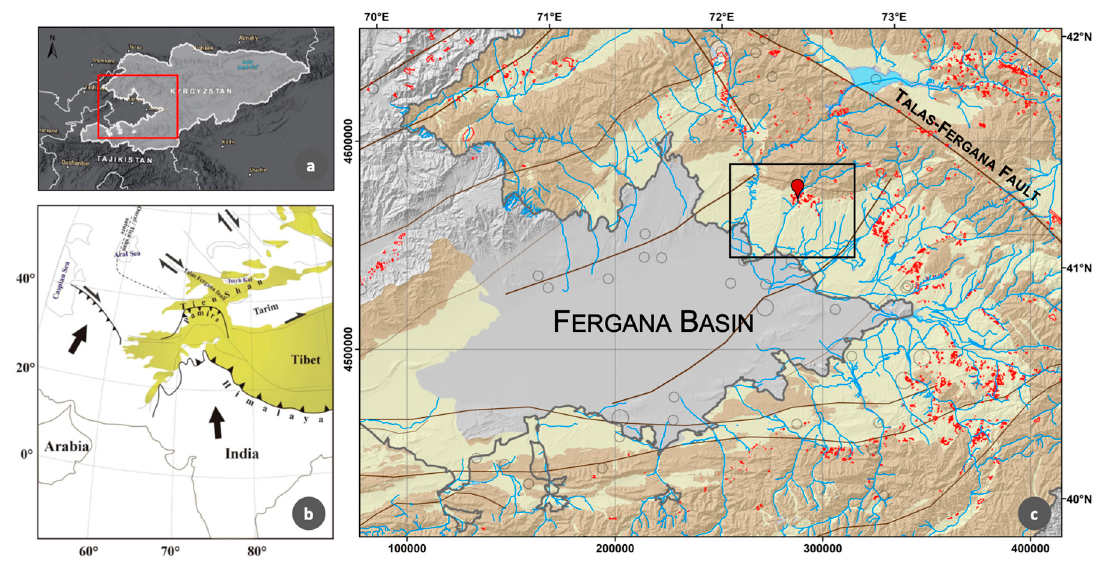
Figure 1. ( a ) Location of Kyrgyzstan and the Fergana Basin (see the red square). ( b ) Tectonic map representing the collision between the Eurasian and Indian plates. The regions located at altitudes < 2000 m are colored in green [26]. ( c ) Fergana Basin and the Mailuu-Suu Valley (see the black square) on the simplified geological map of the Western Tien Shan. Zones colored in beige represent Cenozoic, Mesozoic soft rocks, and sediments, while zones in brown indicate Pre-Mesozoic and magmatic rocks. The circles show the location of major (M ≥ 5.5) earthquake epicenters and the red dots represent the landslides (see Havenith et al. [27]). The red pin shows the location of the town of Maily-Say, the black and blue lines indicate the faults and the waterbodies respectively.